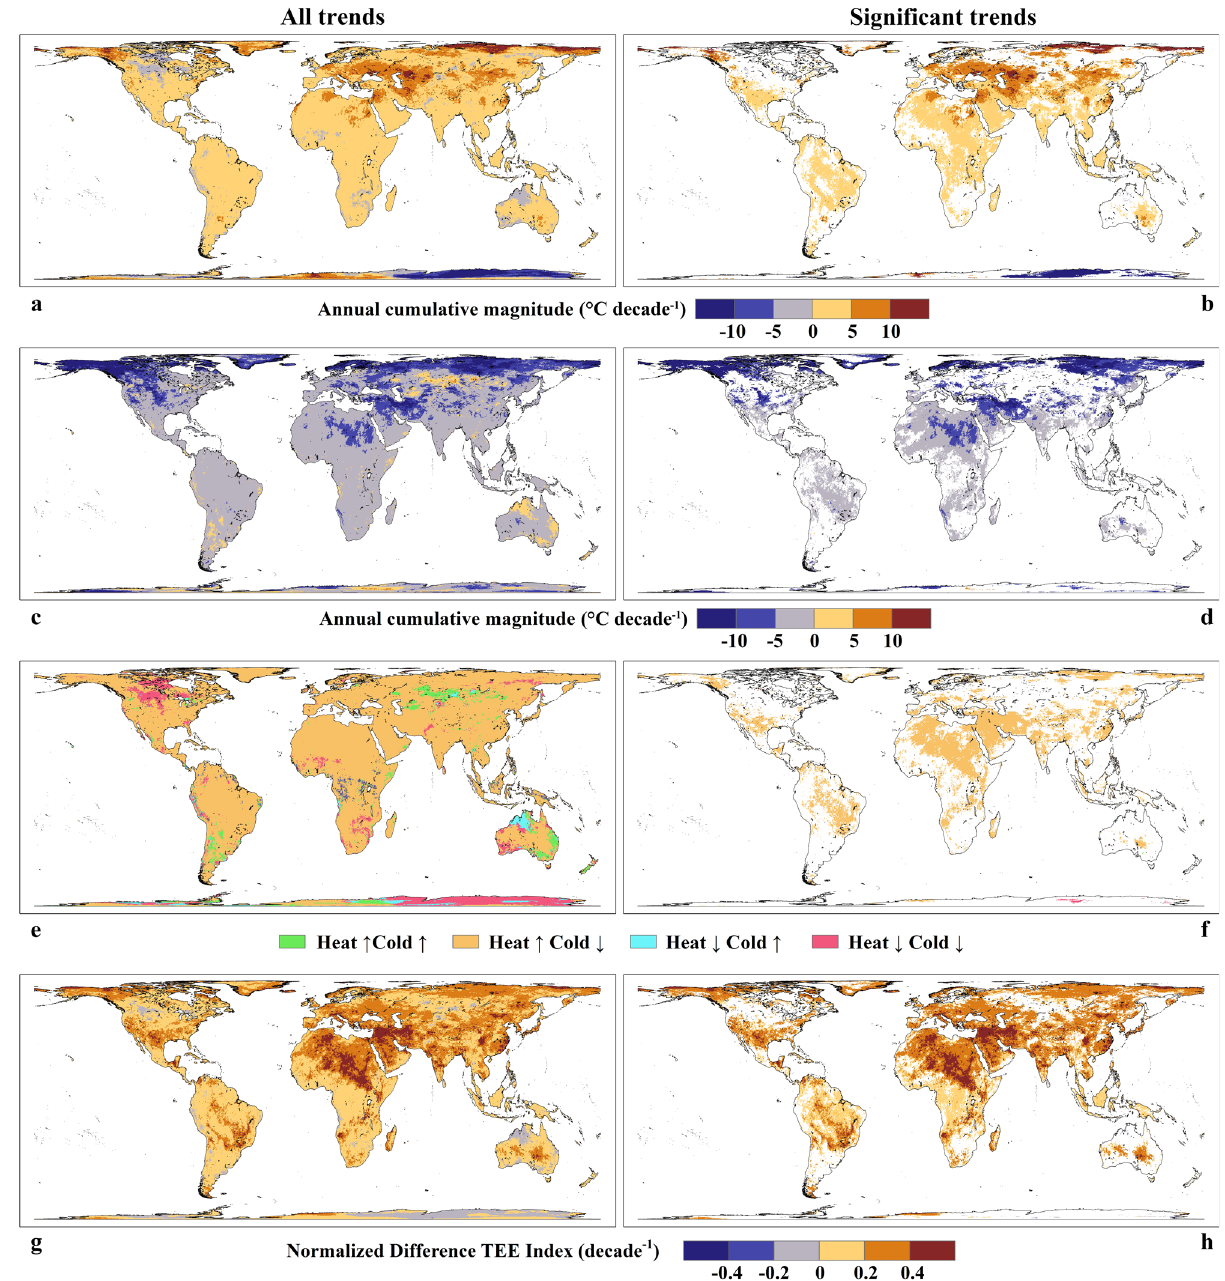
Fig. 5 Global distribution of temporal trends for heat and cold extremes. a , b Trends of annual cumulative magnitude ( M ) for heat extremes. c , d Trends of M for cold extremes. e , f Classes of trend combinations. g , h Trends of Normalized Difference TEE Index (NDTI). Trends were estimated for 1980 – 2018 using Mann – Kendall test and Theil – Sen method, and b , d , f , and h show only signi fi cant trends at the 5%